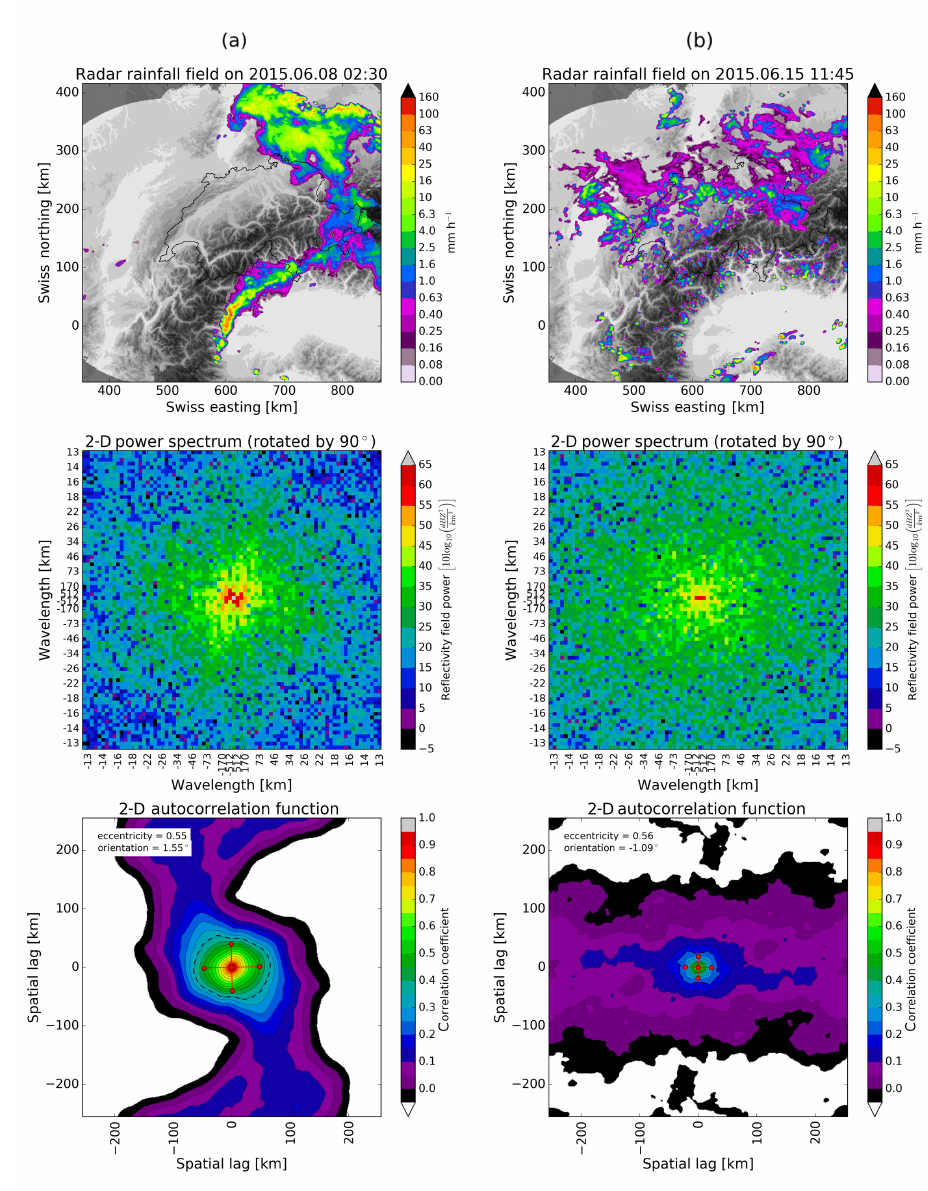
Figure 9. Radar rainfall fields (top row), 2-D Fourier spectra zoomed on wavelengths >13km and rotated by 90 ◦ (centre row) and corre- sponding 2-D autocorrelation functions (bottom row) for case studies on (a) 8 June 2015 and (b) 15 June 2015. More details are provided in the caption of Fig.